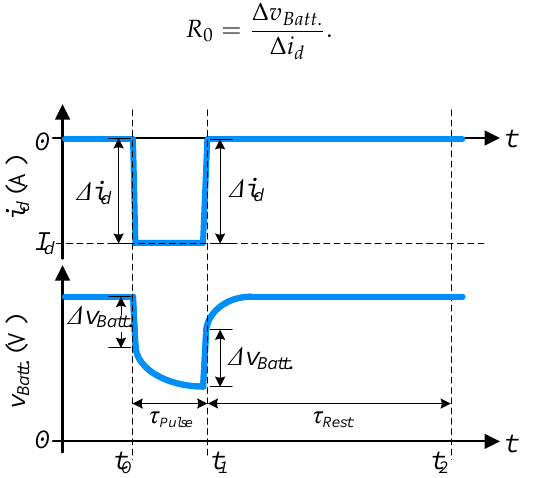
Figure 4. Schematic representation of the discharge pulse and the resulting battery voltage used to estimate R 0 . String current i d (top) and battery voltage v Batt . (bottom) are